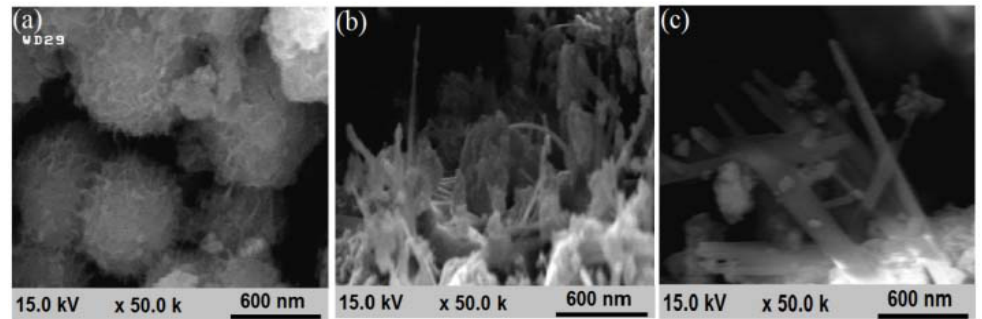
Fig. 4. FE-SEM images of TiO nanorods in (a) pure state (b) doped state with 6 h reflux and (c) 12 h reflux. 2